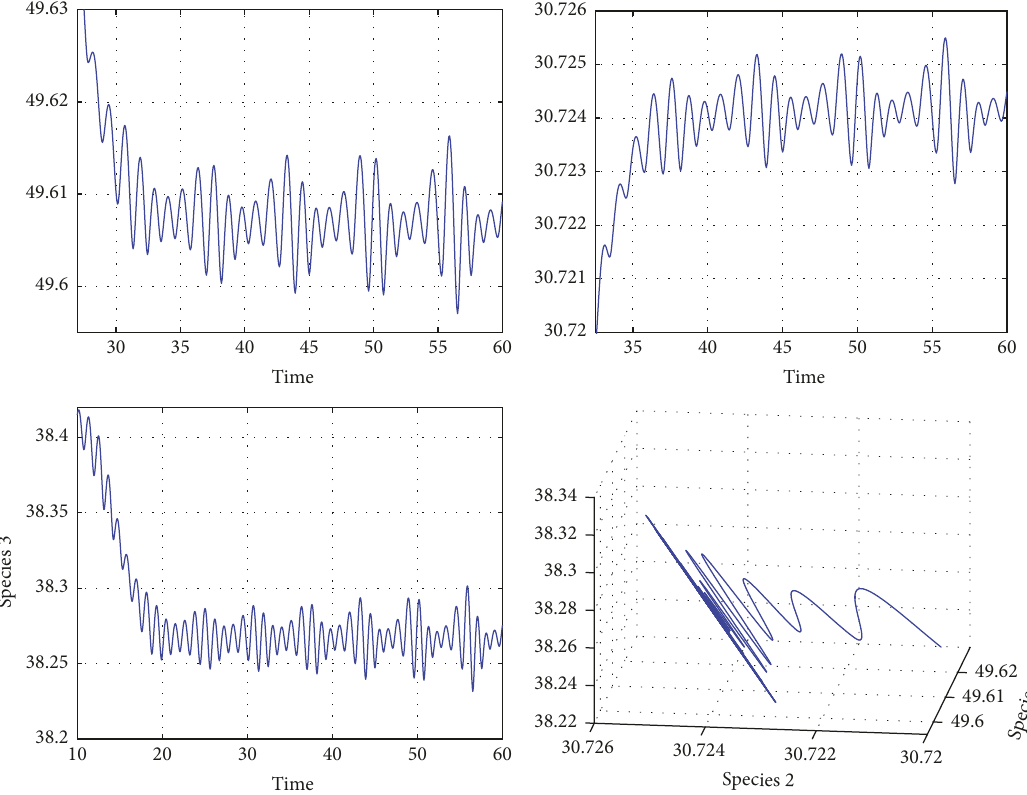
Figure 2: Dynamical behaviors and phase space trajectories of the three marine